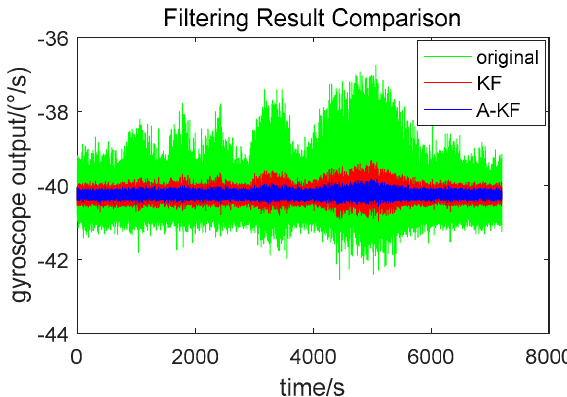
Figure 8. Long term data comparison between the proposed method and KF method.